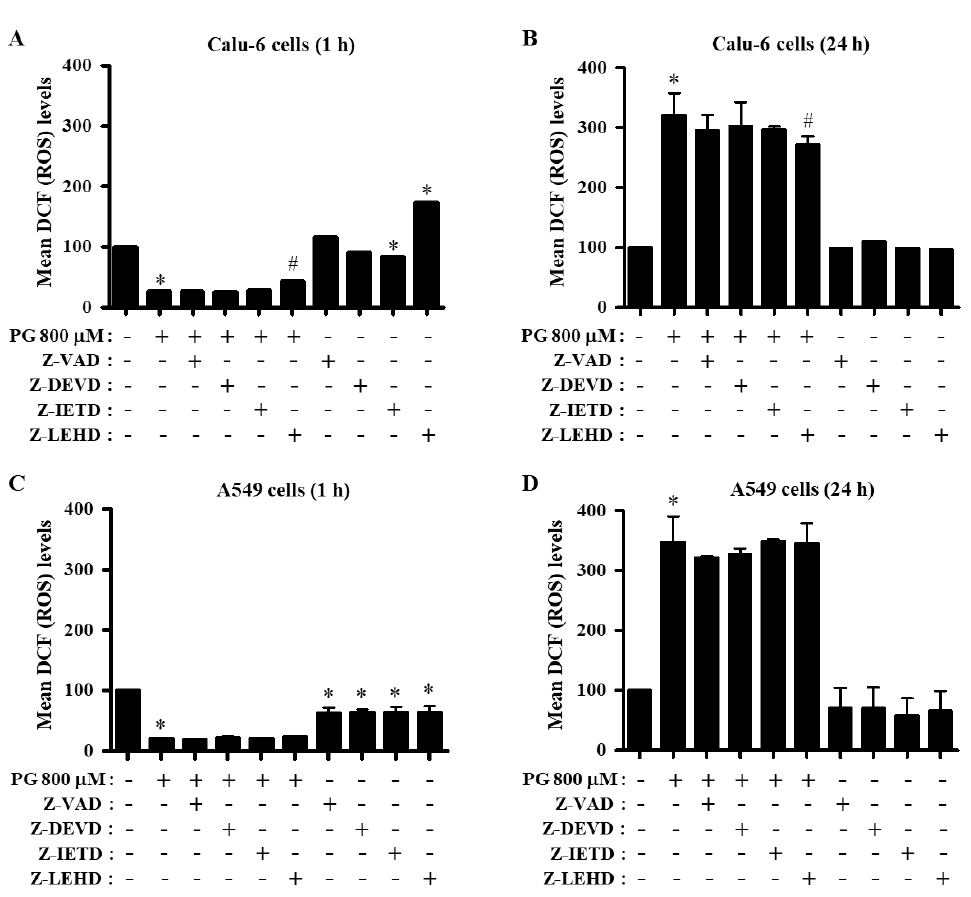
Figure 5. Effects of PG and caspase inhibitors on intracellular DCF (ROS) levels in lung cancer cells. Exponentially growing cells were incubated with 800 µ M PG and/or each caspase inhibitor (15 µ M) for 1 or 24 h. DCF (ROS) levels in lung cancer cells were measured using a FACStar flow cytometer. ( A , B ): Graphs indicate mean DCF (ROS) levels (%) in Calu-6 cells at 1 h ( A ) or 24 h ( B ) compared with control cells. ( C , D ): Graphs indicate mean DCF (ROS) levels (%) in A549 cells at 1 h ( C ) or 24 h ( D ) compared with control cells. * p < 0.05 compared with the PG-untreated control group. # p < 0.05 compared with cells treated with PG only.